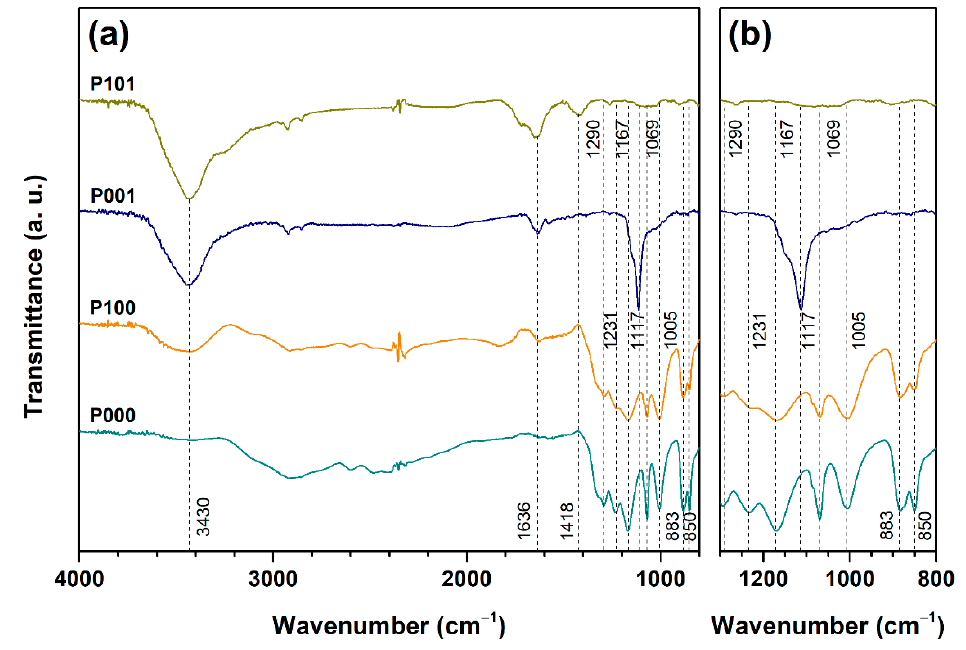
Figure 8. FTIR spectra of GBS products obtained using K 2 S 2 O 8 oxidizing agent in the region of 4000–800 cm − 1 ( a ) and 1300–800 cm − 1 ( b ).